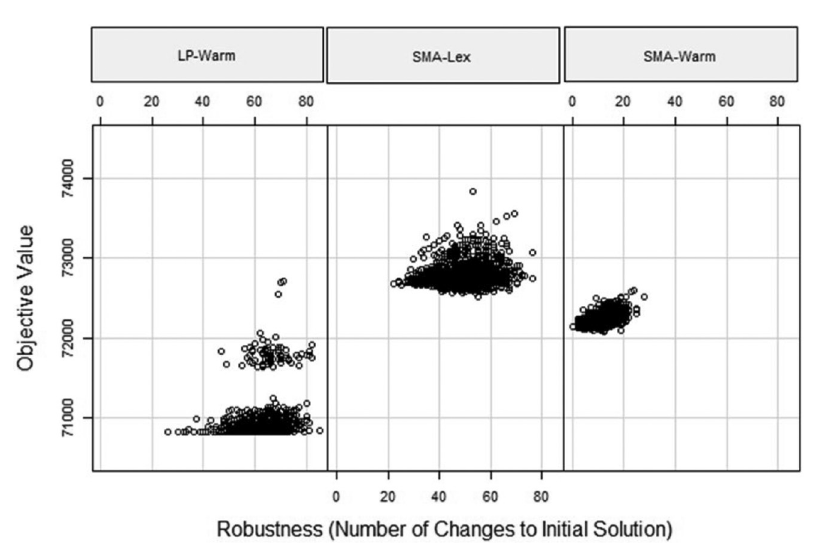
Figure 3. Developing the ef fi cient frontier